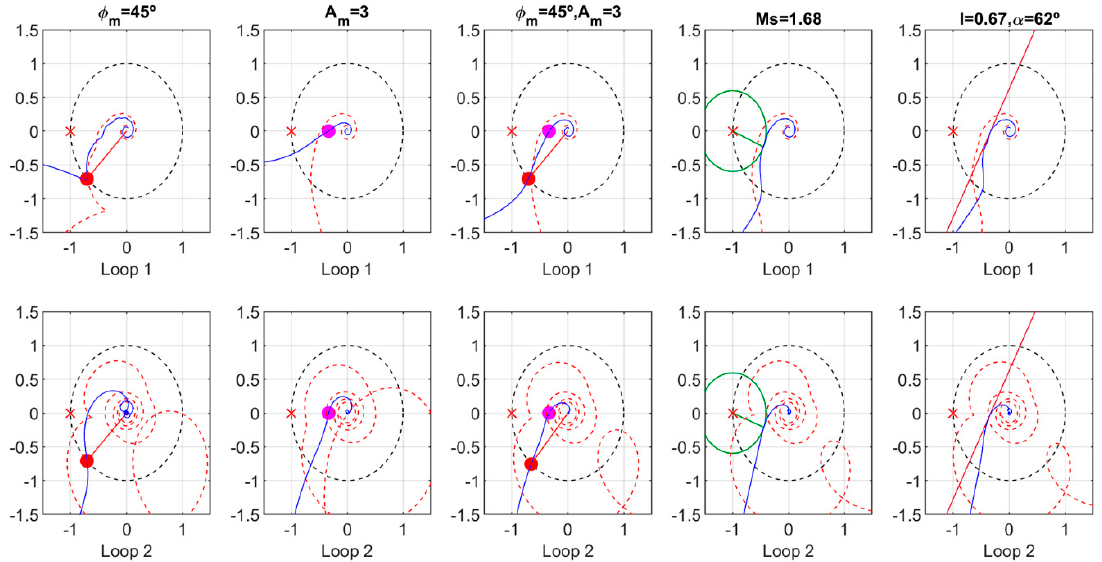
Figure 10. Nyquist diagrams obtained with the proposed controllers in example 1 (each column corresponds to one design). The effective open loop process (EOP) is in a dashed red line and the loop (EOP with controller) in a solid blue line.